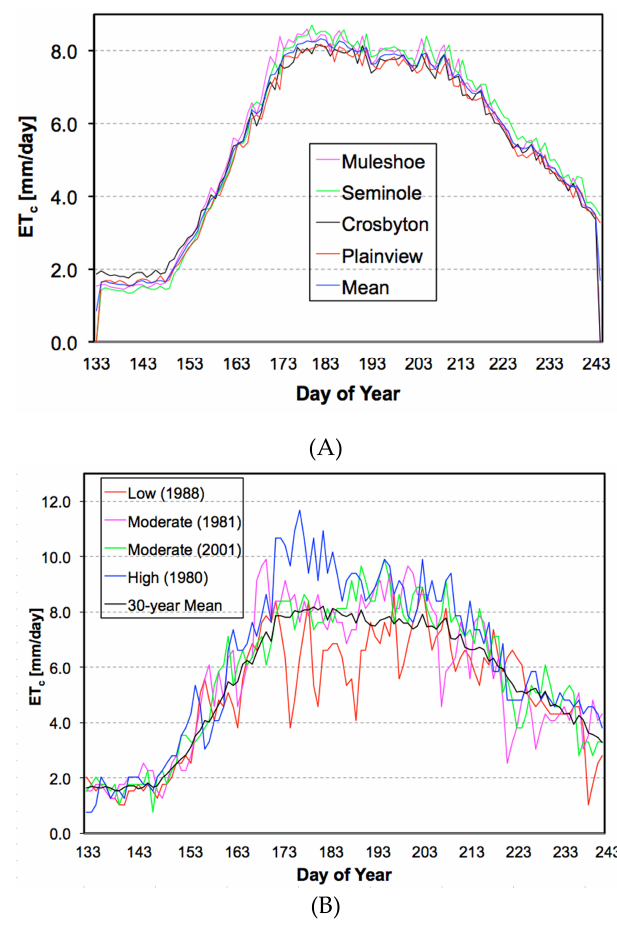
Figure 2. ( A ) The 30-year mean daily cotton ET (ET c ) for four locations across the THP over